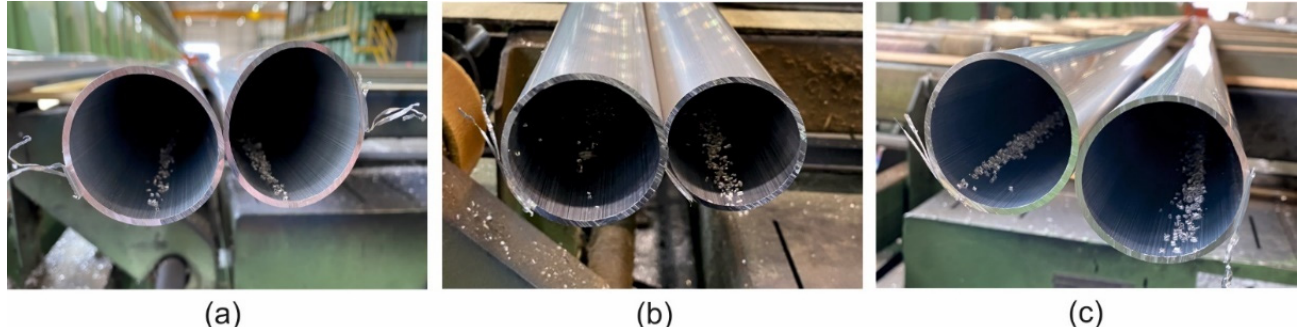
Figure 13. Tubes of Ø50 × 2 mm extruded from 7021 alloy in cross-section by using different dies— die 1 a ), die 2 b ) and die 3 c ).